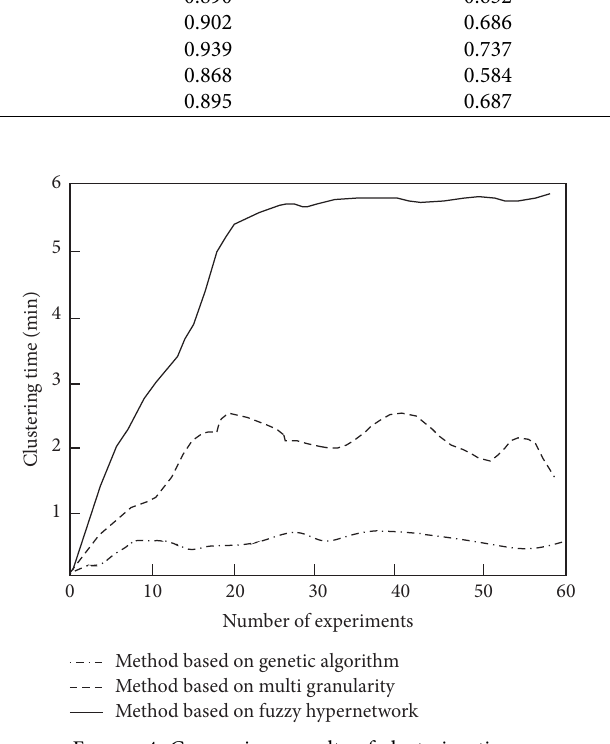
Figure 4: Comparison results of clustering time.